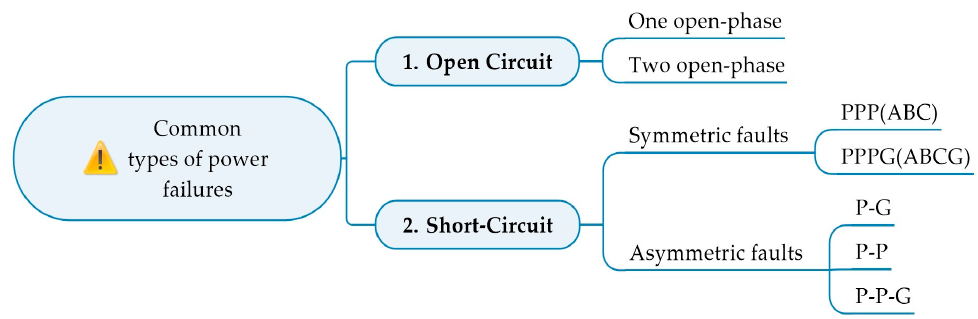
Figure 3. Common types of power failures (open circuit and short circuit failures).